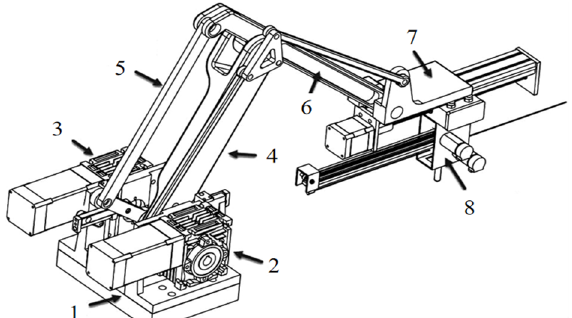
Figure 2. Structure of the cantilevered prostate seed implantation robot. 1. Base; 2. Joint 1; 3. Joint